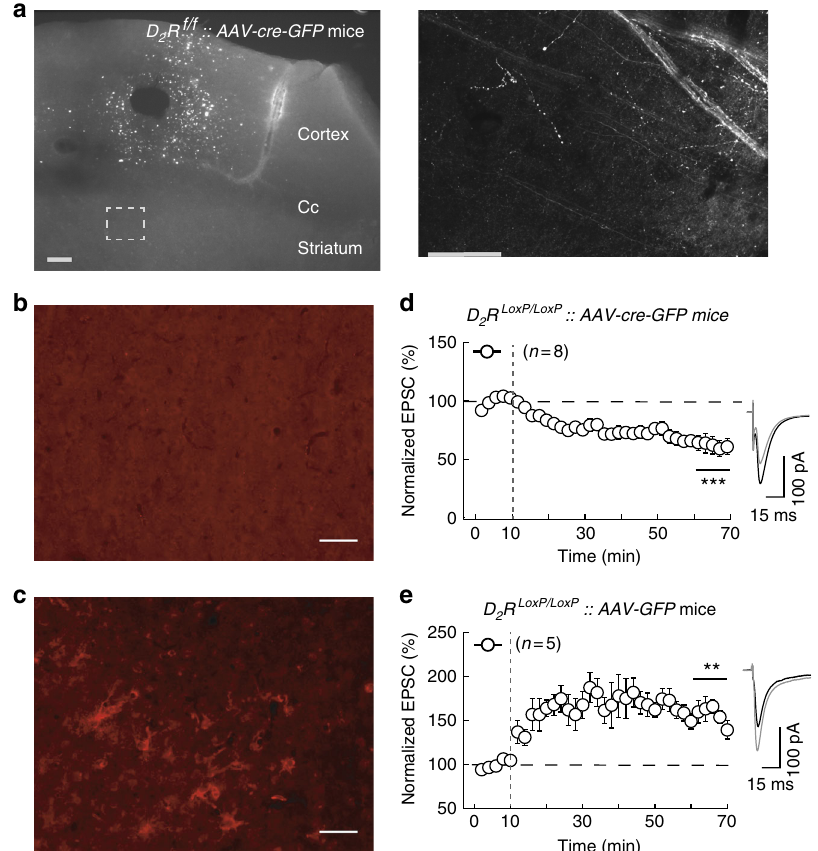
Fig. 7 eCB-tLTP depends on D 2 R expressed by cortical pyramidal cells. a GFP fl uorescence in D 2 R LoxP/LoxP injected with AAV-cre-GFP in somatosensory cortex. Left panel: site of injection of the AAV-cre-GFP and the resulting fl uorescence in pyramidal cells in somatosensory cortex (scale bar: 250 µ m). Note that the fl uorescence is restricted to neurons within cortex and does not cross corpus callosum (Cc). Right panel: GFP fl uorescence in corticostriatal afferents within dorsal striatum (scale bar: 100 µ m). b , c D 2 R immunostaining in the somatosensory cortex of D 2 R LoxP/LoxP mice injected with AAV-cre- GFP ( b ) or with AAV-GFP ( c ); (scale bar: 100 µ m). d , e Experiments of plasticity expression in cKO mice for D 2 R expressed at corticostriatal glutamatergic afferents. d 15 post-pre pairings failed to induce tLTP in D 2 R LoxP/LoxP mice injected with AAV-cre-GFP in somatosensory cortex ( n = 8, 0/8 and 7/8 cells showed tLTP and tLTD, respectively). e As a control, tLTP was induced with 15 post-pre pairings in D 2 R LoxP/LoxP mice injected with AAV-GFP ( n = 5, 5/5 cells showed tLTP). Representative traces are the average of 15 EPSCs during baseline (black traces) and 45 min after STDP protocol (grey traces). Vertical grey dashed line indicates the STDP protocol. Error bars represent sem. ** p < 0.01; *** p < 0.001 by one sample t -test ( d , e